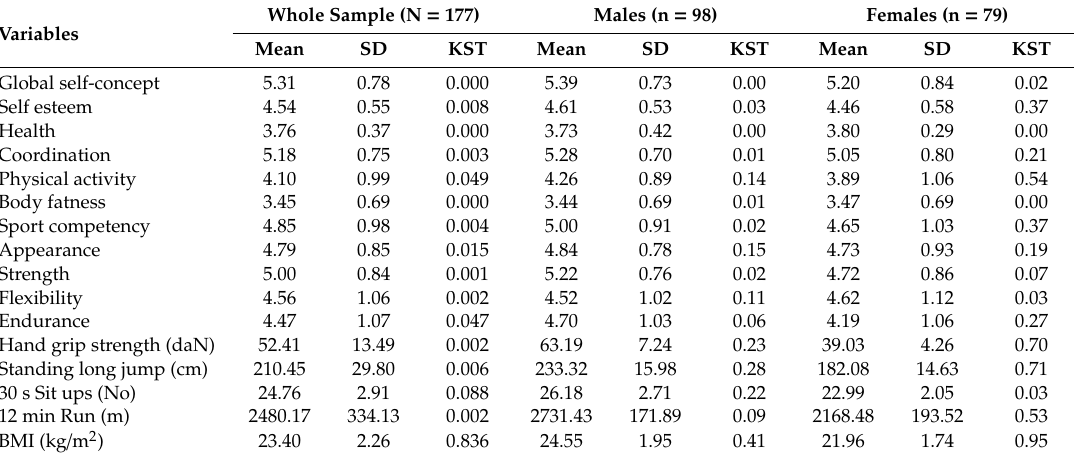
Table 1. Descriptive statistics for male and female police